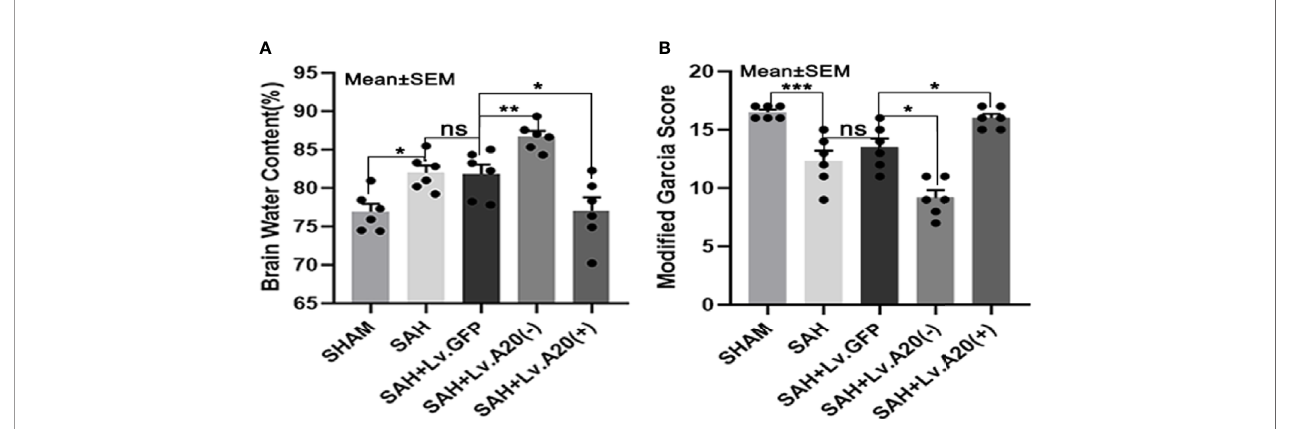
FIGURE 8 | A20 attenuates brain edema and neurological de fi cits to exert a neuroprotective role. (A) Dry/wet weight ratio data represent brain water content. A20 ameliorated brain edema after SAH. (B) Modi fi ed Garcia score results showed that A20 remarkably improved neurological de fi cits in mice at 24 h after SAH. Data are expressed as mean ± SEM, n = 6, * p < 0.05, ** p < 0.01, *** p < 0.005, ns versus SAH. ns, non-signi